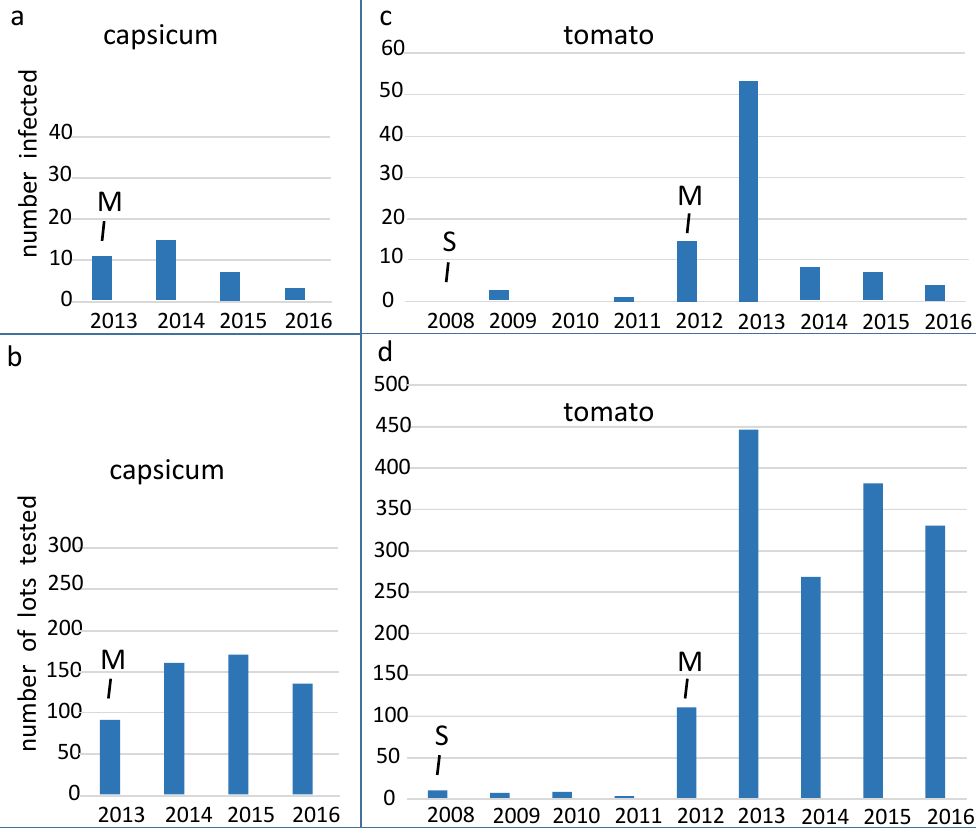
Figure 1. Variation in the numbers of infected seed lots detected each year. ( a ) The numbers of infected capsicum seed lots and ( b ) the numbers of capsicum seed lots tested each year by Australian laboratories, and ( c , d ) equivalent counts of infected tomato seed lots and numbers of tomato seed lots tested. Testing of tomato seed for Potato spindle tuber viroid (PSTVd) started in 2008 (S) but only a small fraction of imports was tested. Testing of tomato seed imports became mandatory in 2012 (M), and the full suite of tests for the viroids was introduced early in 2013, but data was not compiled for all tested seed lots until 2013. Mandatory testing of capsicum (chilli, pepper and capsicum) seed was introduced in 2013